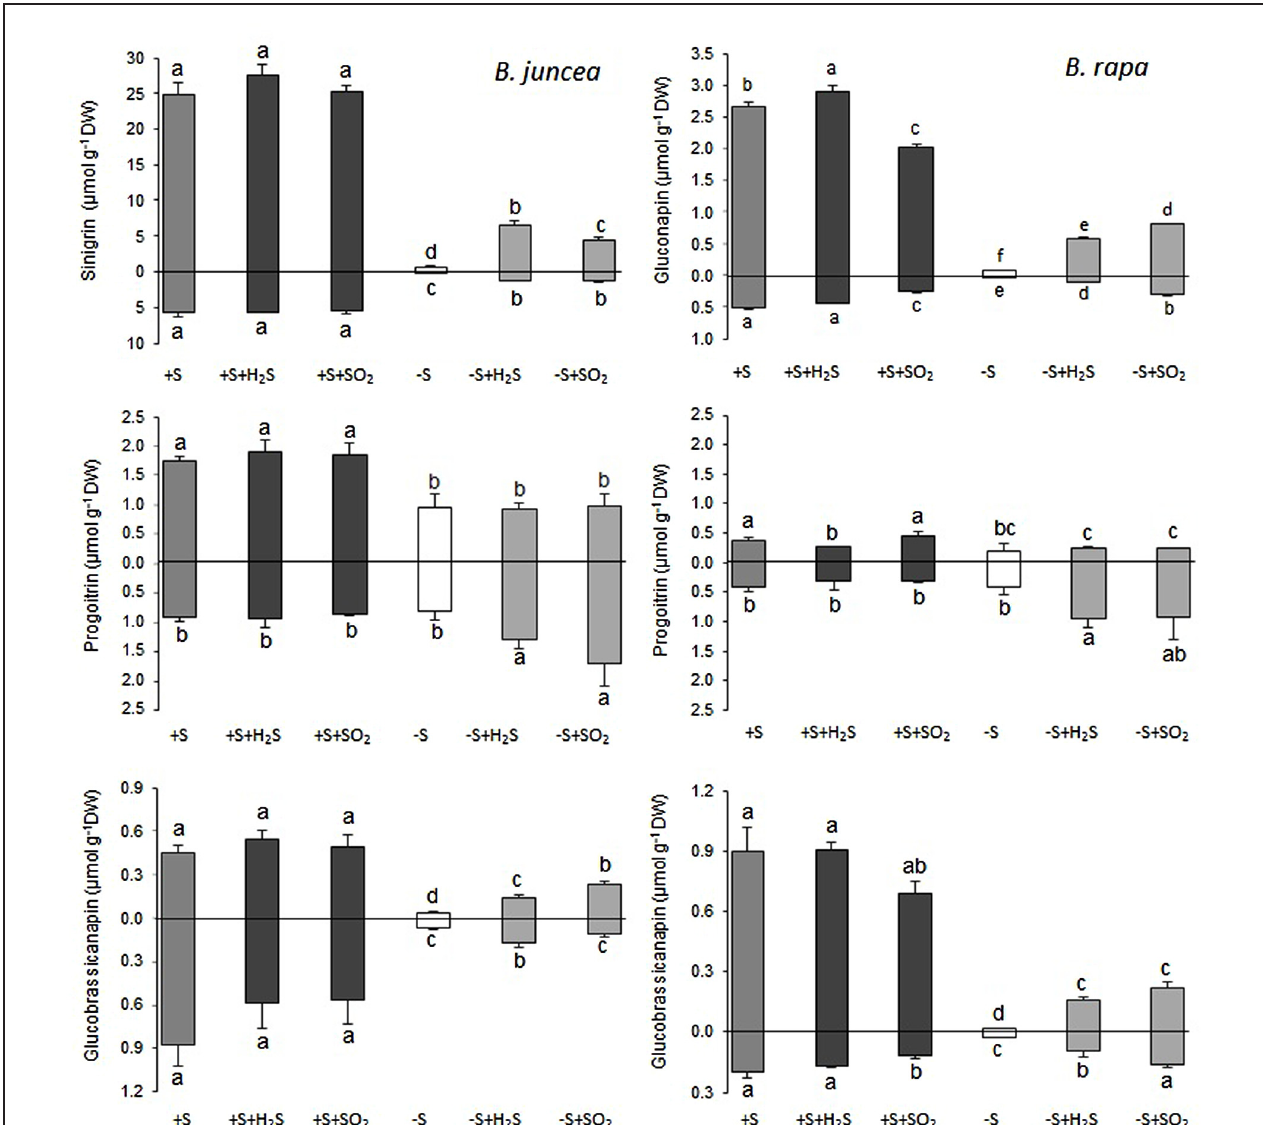
FIGURE 3 | Impact of H 2 S and SO 2 and sulfate deprivation on the content of the aliphatic glucosinolates in shoots (above x axis) and roots (below x axis) of B. juncea and B. rapa . For experimental details, see legends of Figure 1 ; for details on their nomenclature see Table 1 . Data on glucosinolate content ( μ mol g − 1 DW) represent the mean of three measurements with nine plants in each ( ± SD). Different letters indicate significant differences between treatments ( P < 0.01, Student’s t